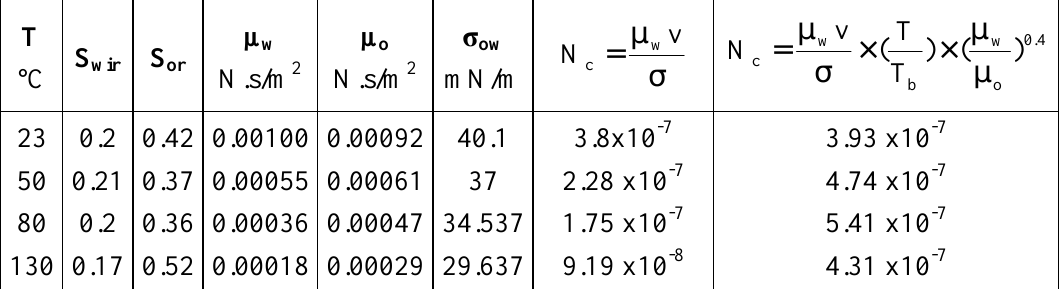
Table 2. Capillary number determination as a function of temperature, IFT and viscosity.